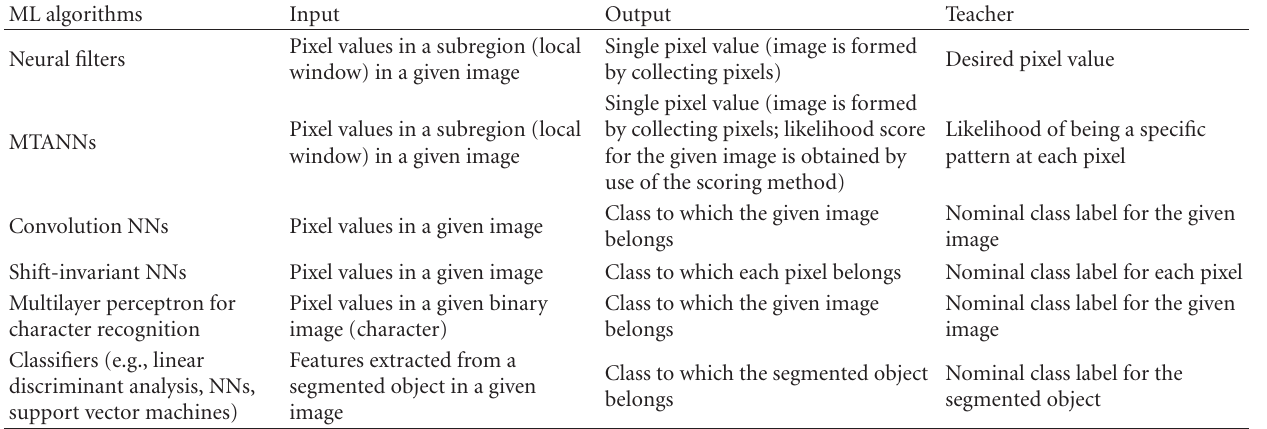
Table 2: Classification of ML algorithms by their input, output, and teacher (desired output).